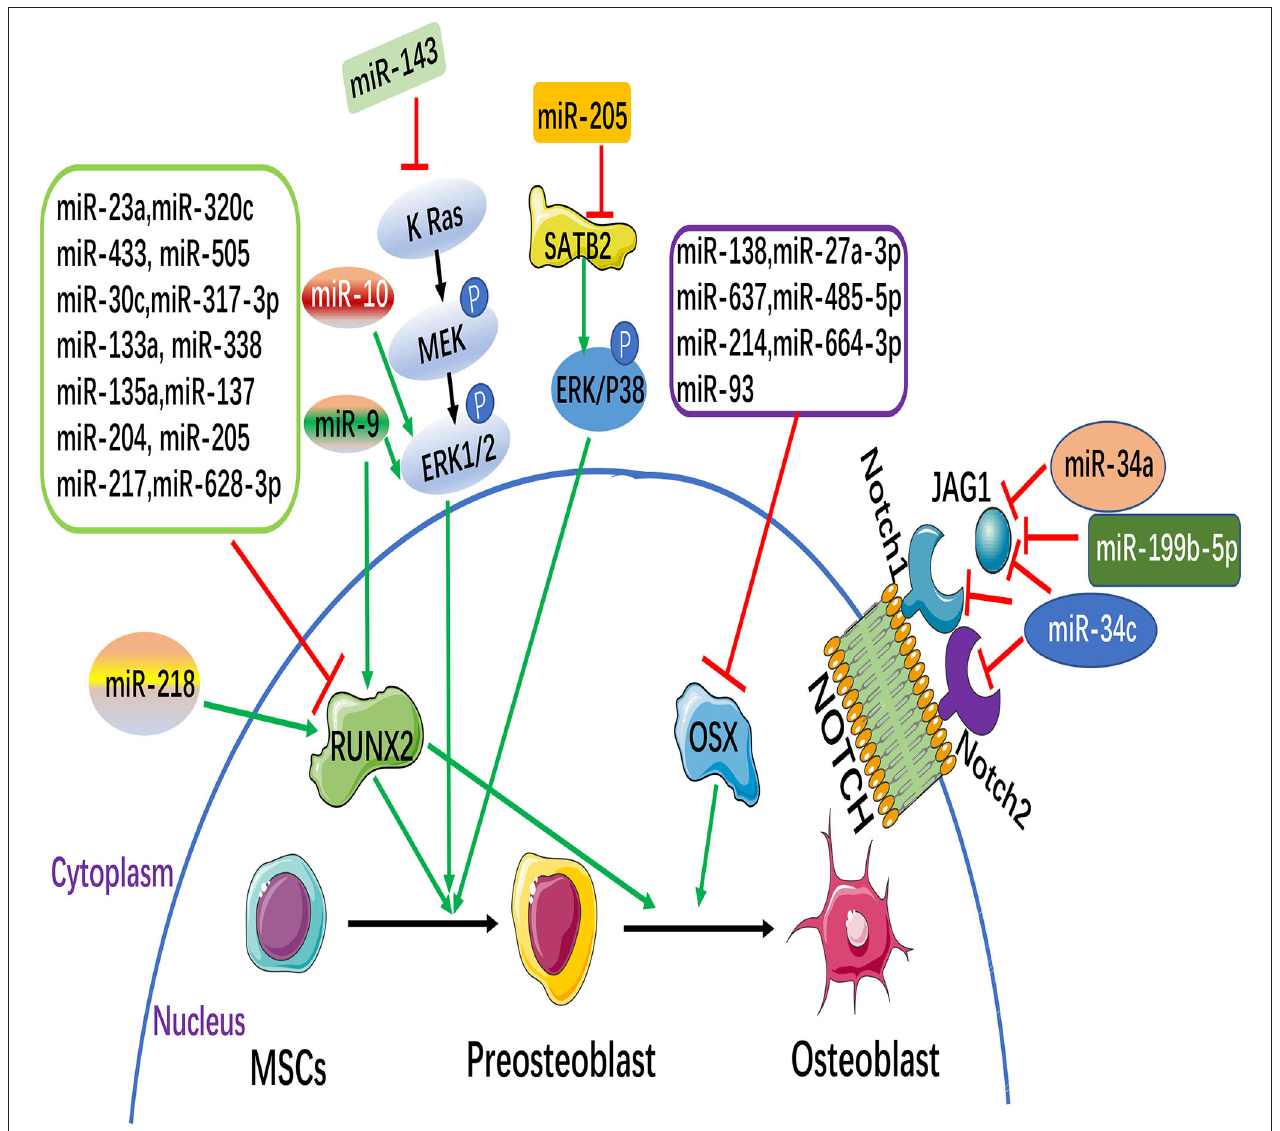
FIGURE 1 | MicroRNAs (miRNAs) and signaling pathways involved in the osteogenesis of mesenchymal stem cells (MSCs). MiRNAs can inhibit or promote osteoblast differentiation through the direct targeting of their target genes, some of which are osteoblastic markers [such as runt-related transcription factor 2 (Runx2) and osterix (Osx)]. Notch and MAPK signaling pathways participate in regulating the osteoblastic differentiation of MSCs. (The green arrow: promotion, Red symbol: